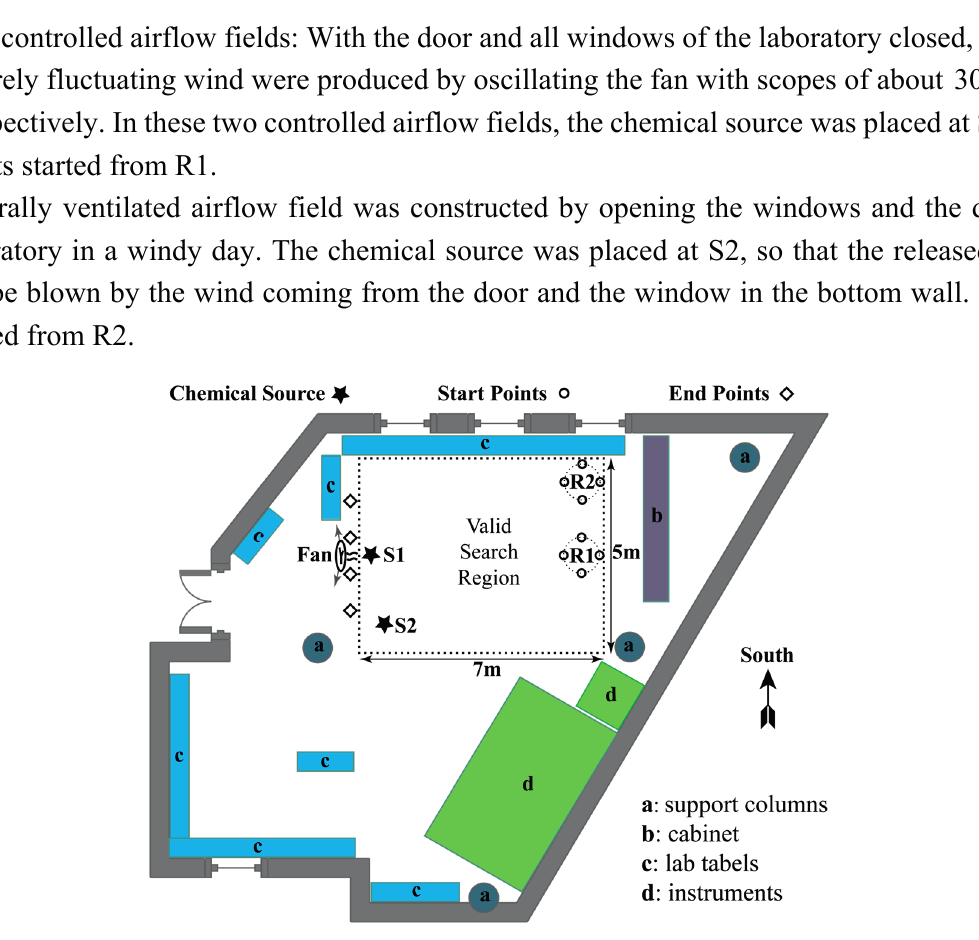
Figure 8. Plan sketch of the laboratory. The valid search region is represented as a rectangular area with dotted